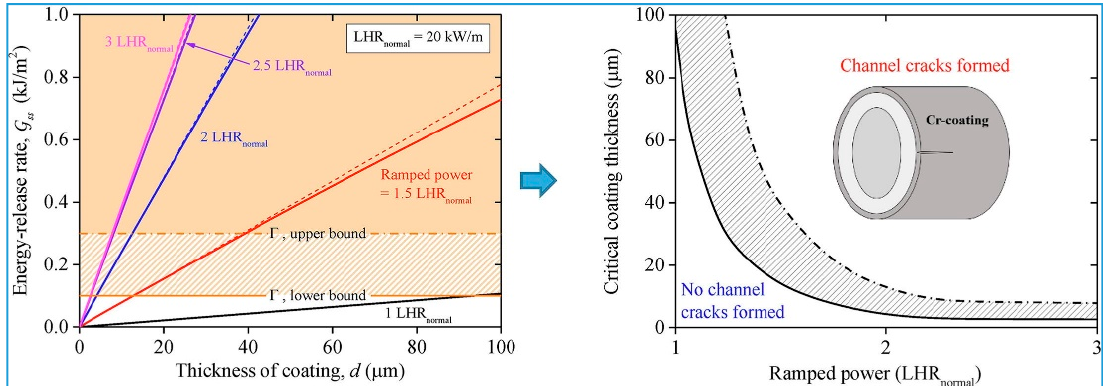
Figure1. ComparisonoffatiguebehaviorofCrCS-coatedZr-4sheetanduncoatedsamples. Reproduced from the work in [12] with copyright permission from the American Nuclear Society (ANS) and the author.